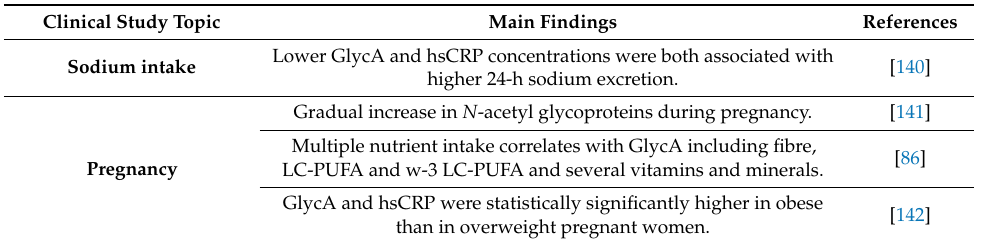
Table 4. Summary of 1 H-NMR glycoprotein’s clinical applications. (c) Other